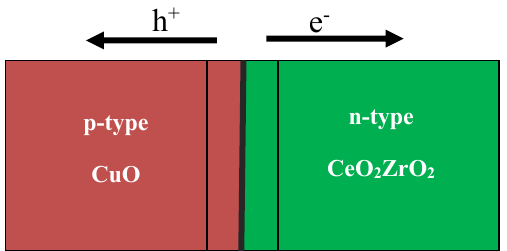
Fig. 9. p–n junction formation model and the schematic diagram of electron-hole separation